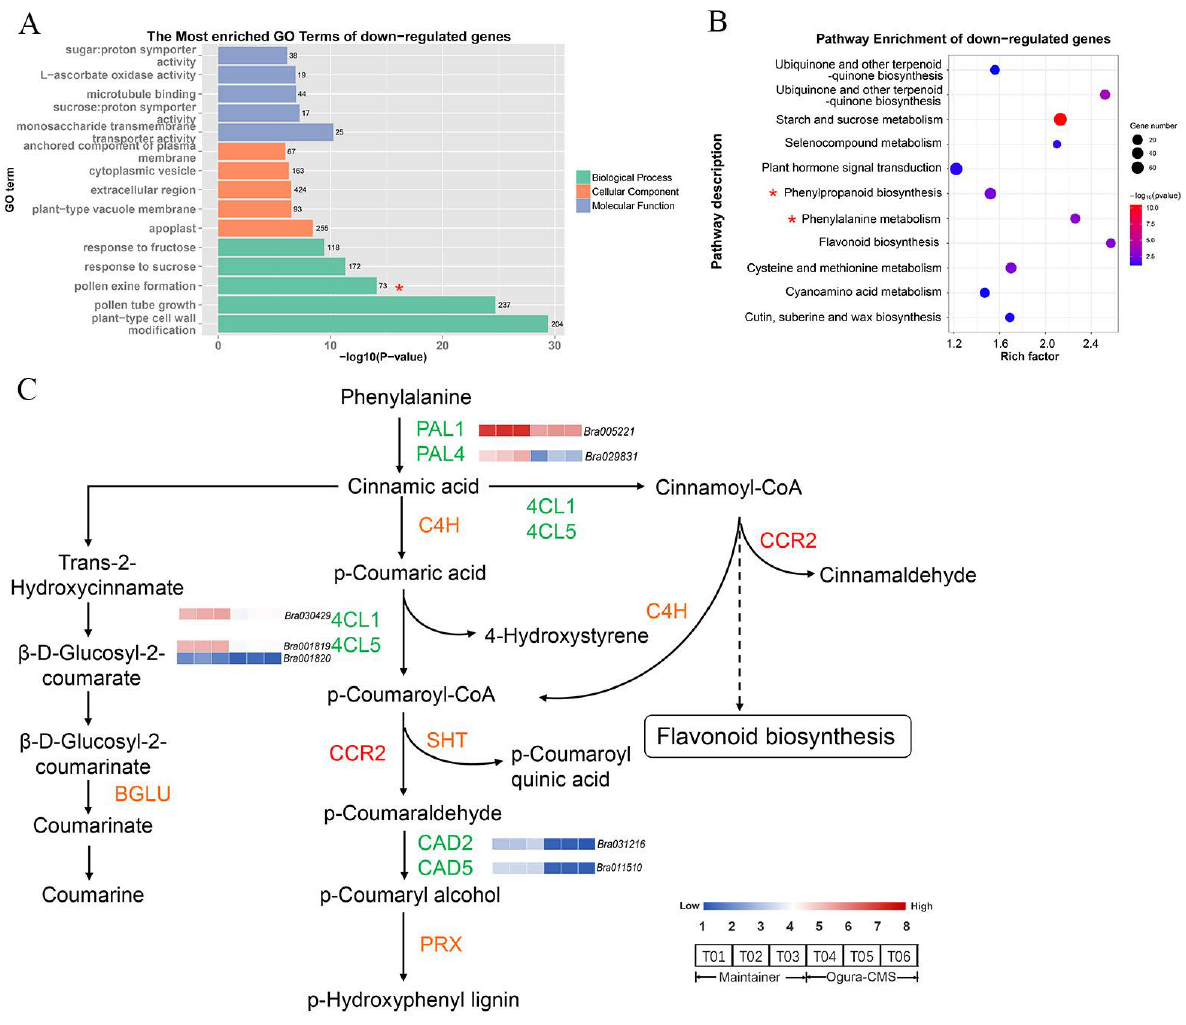
Figure 6. Enrichment analysis of genes down-regulated in the maintainer line vs. the Ogura CMS line. ( A ) GO analysis of down-regulated DEGs; ( B ) KEGG enrichment analysis about pollen exine formation for down-regulated DEGs; ( C ) pathway of phenylpropane biosynthesis (ko00940). PAL1, phenylalanine ammonia-lyase 1; PAL4, phenylalanine ammonia-lyase 4; C4H, cinnamate 4-hydroxylase; 4CL, 4-coumarate-CoA ligase; SHT, spermidine hydroxycinnamoyl transferase; CAD5, cinnamyl alcohol dehydrogenase 5; PRX, peroxidase; CCR2, cinnamyl-CoA reductase; BGLU, β-glucosidase. The red is the up-regulated enzyme gene; the orange represents the enzyme gene with no change in expression; the green represents the down-regulated enzyme gene. T01, T02 and T03 represented 3 libraries (the maintainer line, 3 times replication); T04, T05 and T06 represented 3 libraries (the Ogura CMS line, 3 times replication).